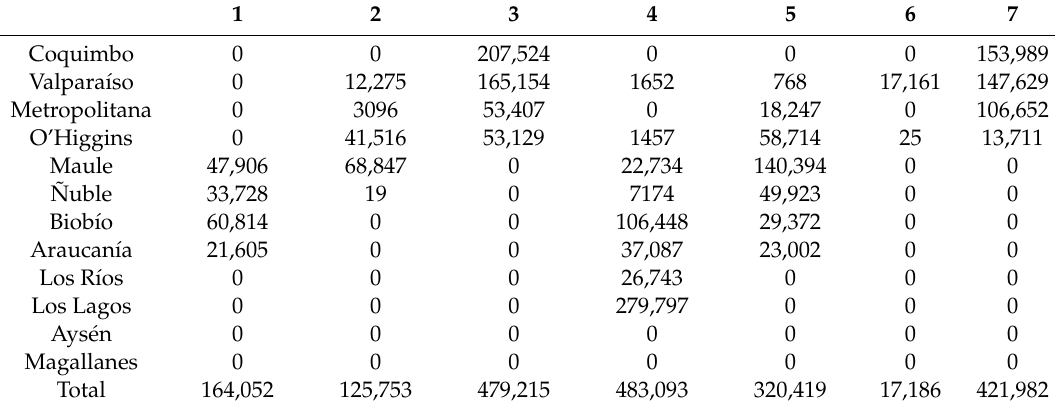
1: Suitable land with a humid regime; 2: Suitable area 3 with a subhumid regime; 3: Marginal area (water deficit); 4: Marginal area (temperature); 5: Marginal area (frost); 6: Marginal area (temperature and water deficit); 7: